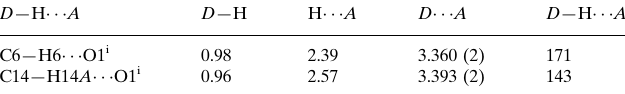
Hydrogen-bond geometry (A˚ , (cid:4)